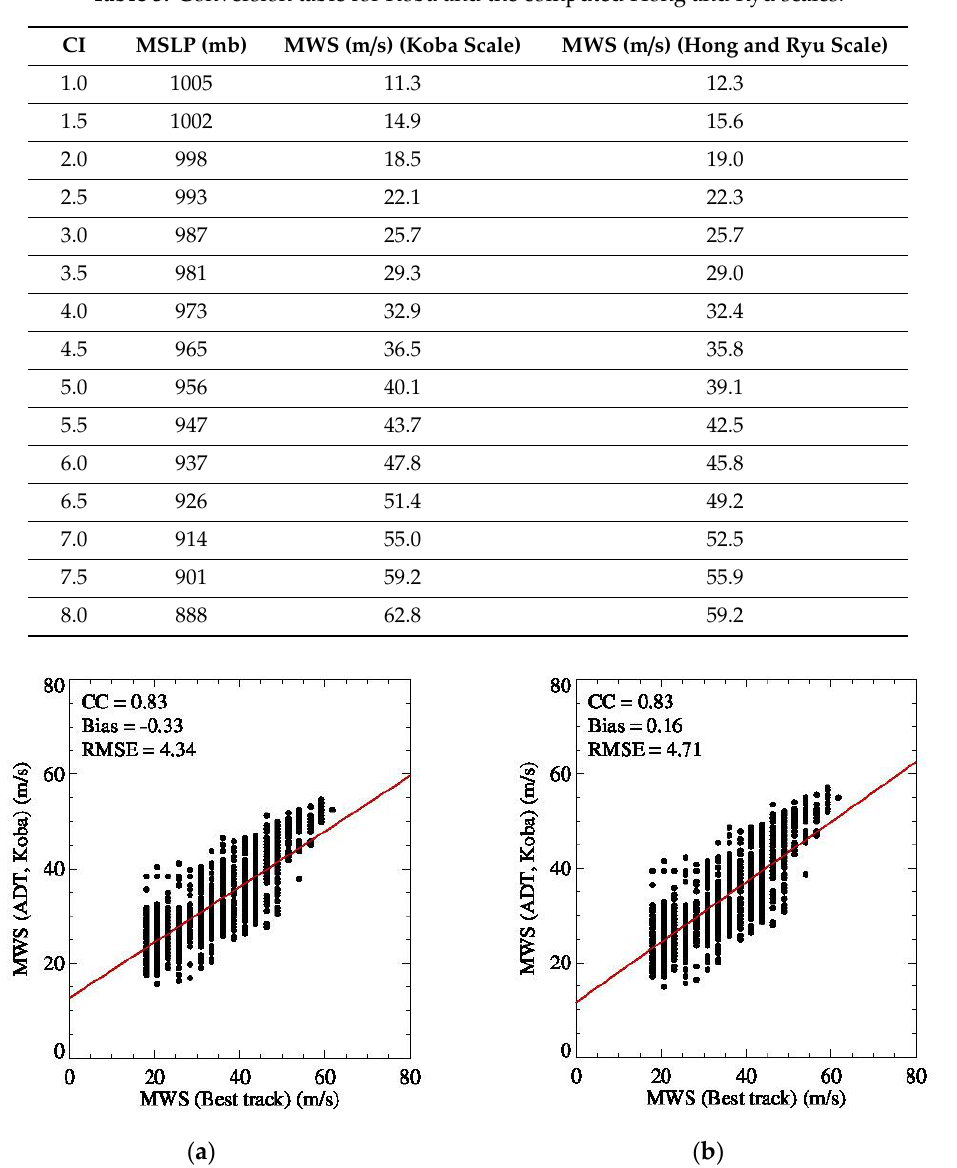
Table 3. Conversion table for Koba and the computed Hong and Ryu scales.